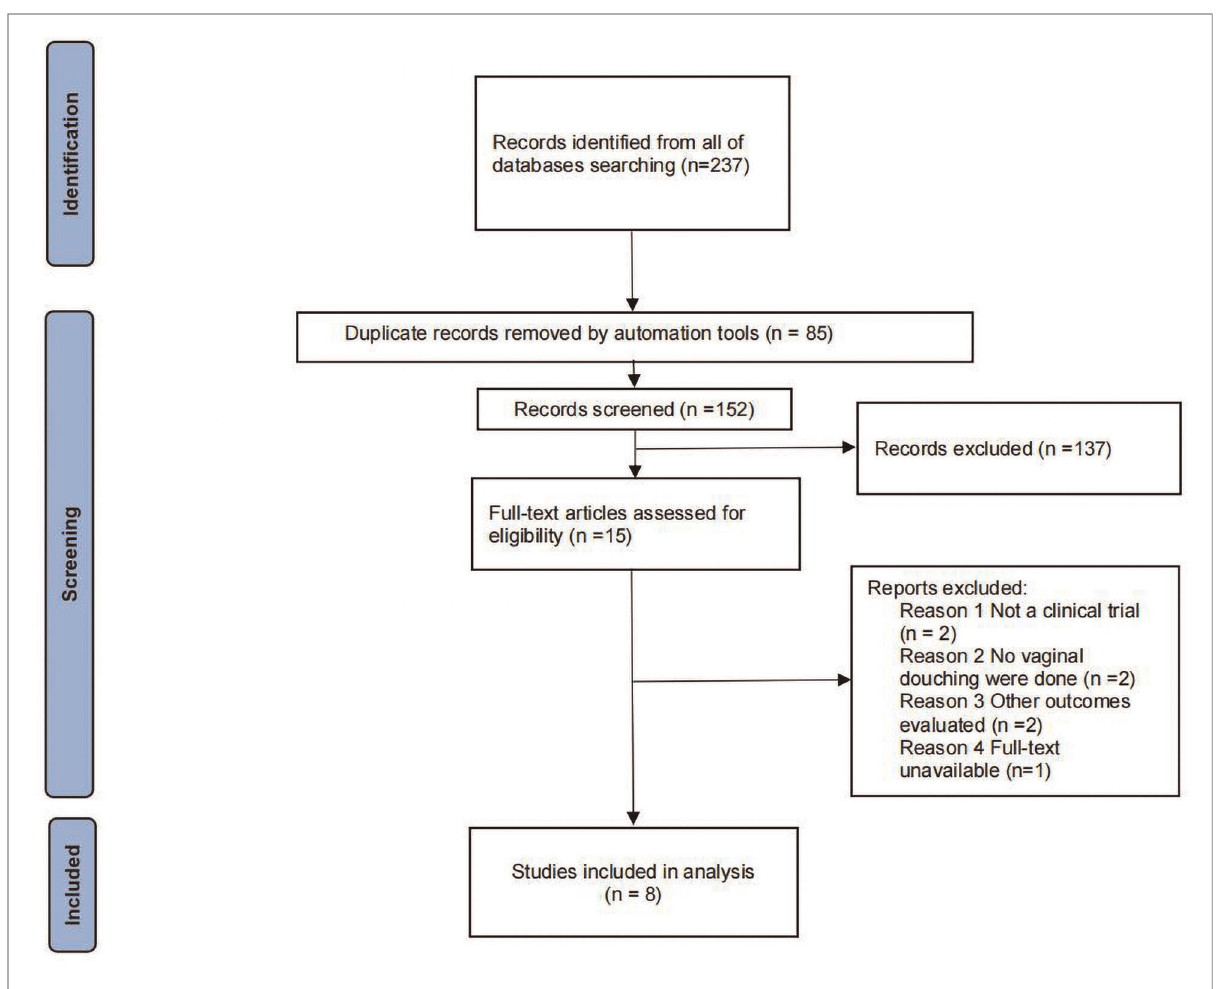
FIGURE 1 Flow diagram of literature selection.